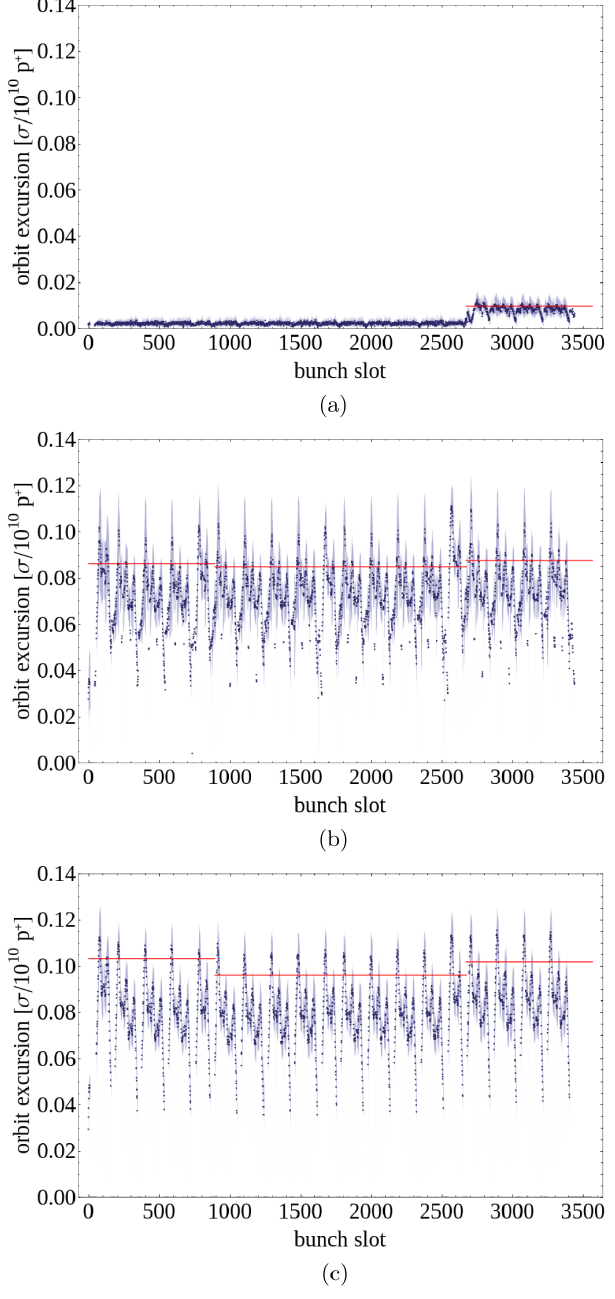
FIG. 18. Comparison between the measurements and the simulations of the loss of the BBK in Beam 2. The blue dots show the mean of all the 14 measurements at 6.5 TeV, with the shaded region around them indicating one standard deviation. The red lines show the estimates from the simulations of the three beam parts. (a) Three turns before dump (b) Two turns before dump (c) One turn before